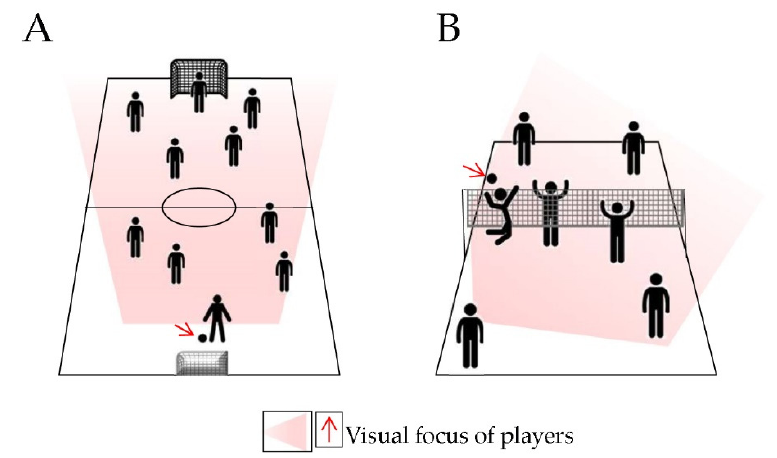
Figure 2. Representative models of soccer ( A ) and volleyball ( B ) fields, players, and game develop- ment. The blurred ray panels ( A , B ) show the visual focus (vison in depth) of players; the red arrows show the visual focus of strikers on the ball.